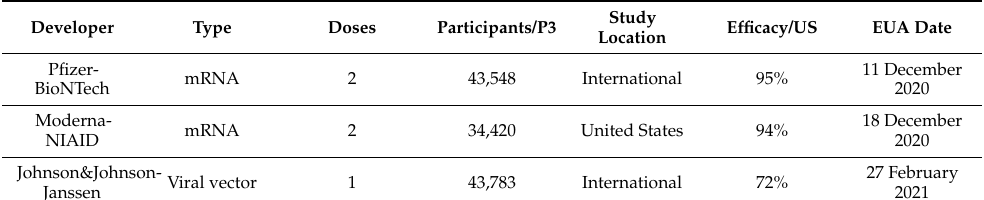
Table 1. SARS-CoV-2 vaccines that received EUA from the